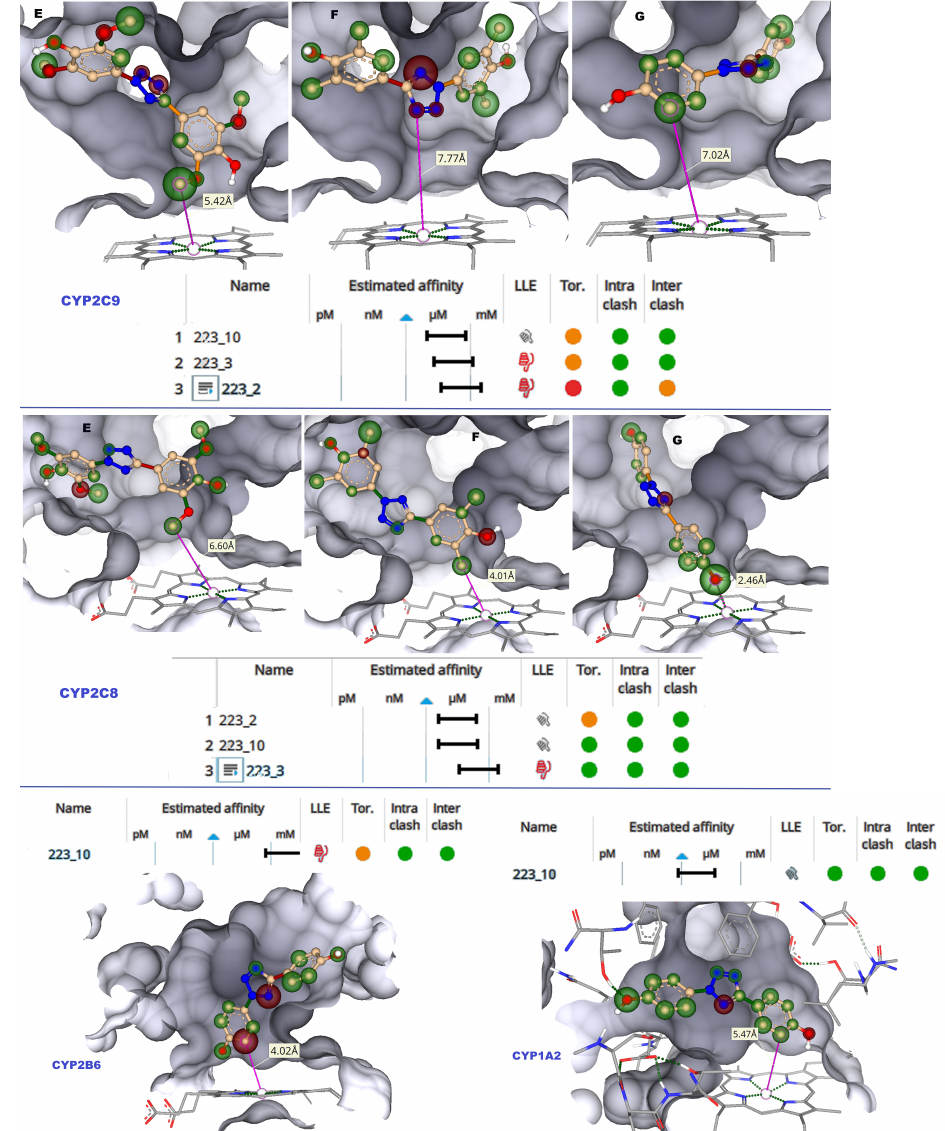
Figure 3. Images of CYP2C9, CYP2C8, CYP2B6, and CYP1A2 LBP docked with TbB ligands visualized with HYDE atomized coloring. White corona = neutrality, a green-colored corona = the ability of this atom to favorably contribute to BA, and a red-colored corona = the ability of this atom to non- favorably contribute to BA. (E) TbB ligand 223-2 atoms in LBP. (F) TbB ligand 223-3 atoms in LBP. (G) TbB ligand 223-10 atoms in LBP. The size of the corona sphere visually indicates the extent of favourable or non-favourable contribution to the BA. Larger spheres indicate more contribution and smaller spheres indicate less contribution to the BA. HYDE binding affinity (Ki) estimation of molecular docked poses of 223-2, 223-3, and 223-10 ligands in the active site of CYPs is represented as the range from mM < µ M < nM < pM. Green circle = favourable to BA. Red circle = non-favourable to BA. BA = binding